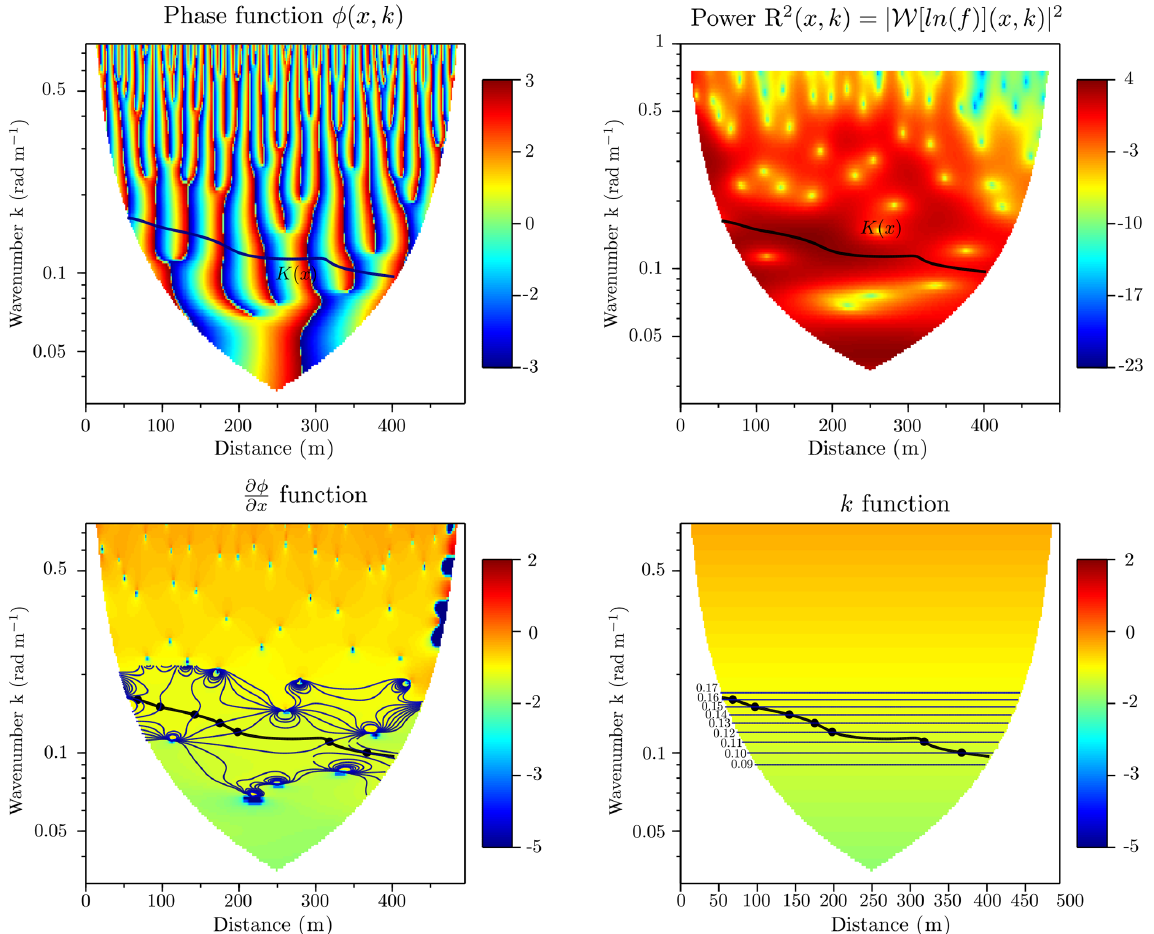
Figure B1. Steps of determining the local wavenumber K(x) using the wavelet univariate ridge analysis of the velocity of the Olivet (3) reach, represented in the four panels. (a) The phase function φ(x,k) ; (b) the power’s cone of influence of the wavelet to characterize the region where there is a maximum variability of the velocity in the Neperian logarithm; (c) the function ∂φ